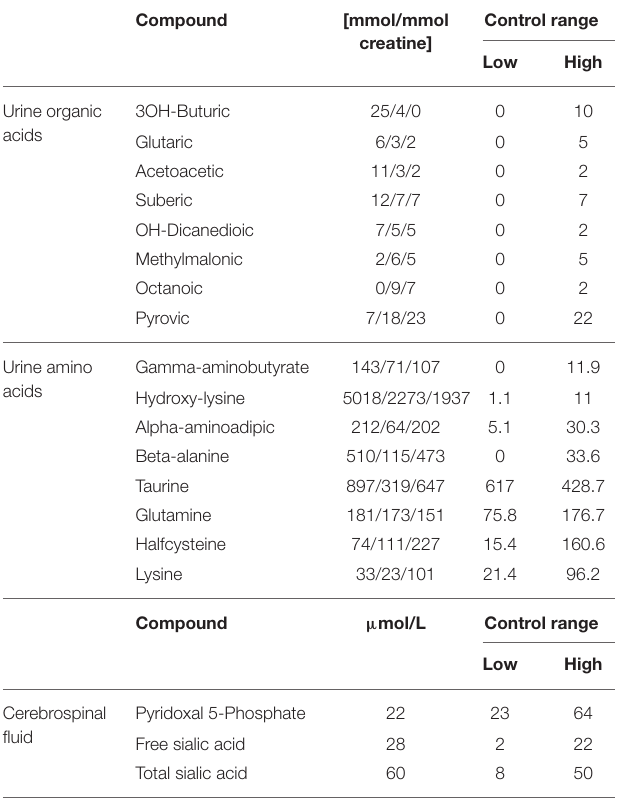
TABLE 1 | Selected metabolite